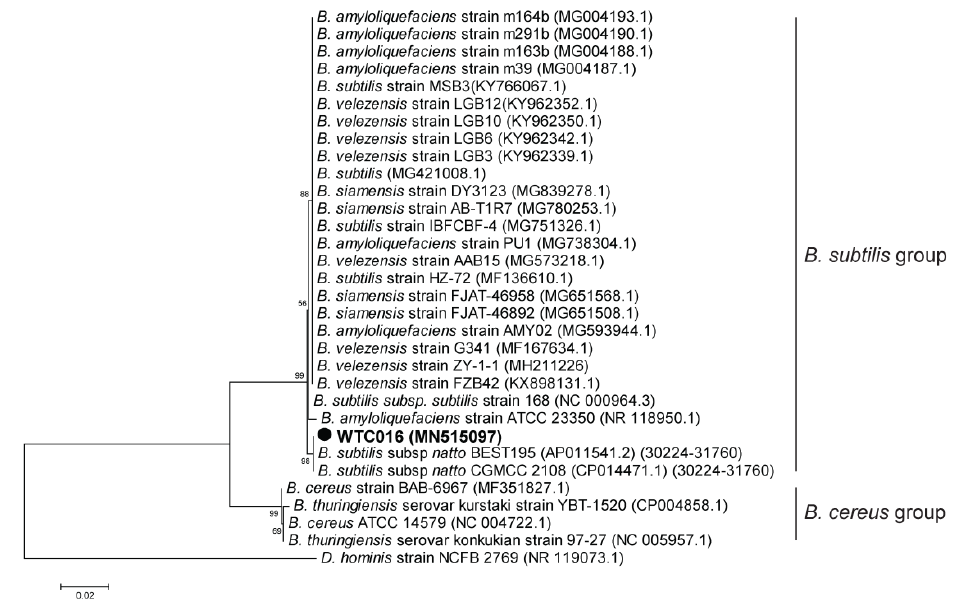
Figure 2. The morphology of vegetative cells ( A ) and spores ( B ) of WTC016.